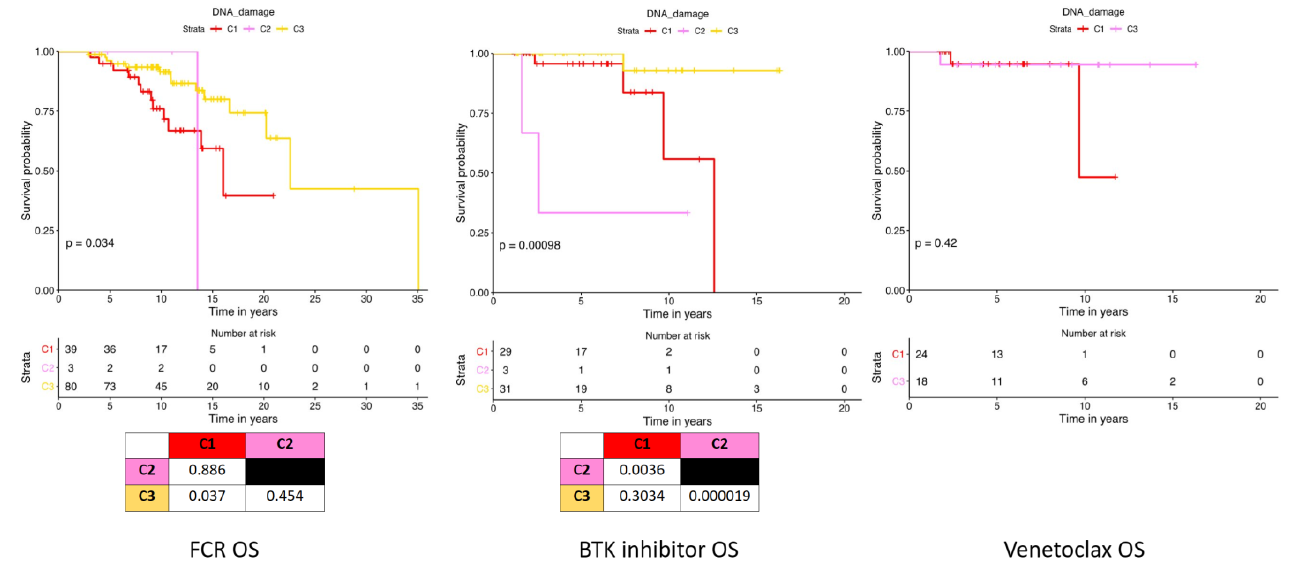
Figure 3. Effect of DDR protein cluster membership on the outcome. Kaplan – Meier plots of the as- sociation between the three DDR protein clusters on overall survival ( Left ), time to first treatment ( Center ), and time to second treatment ( Right ) in all CLL patients is shown. For overall survival, comparisons between patients in C1 and C2 were statistically similar (BH p -value 0.38) but were both distinct from C3 (vs. C1, BH p -value < 0.001 and vs. C2, p -value 0.002). For the time to first and second treatments, there were no significant differences.